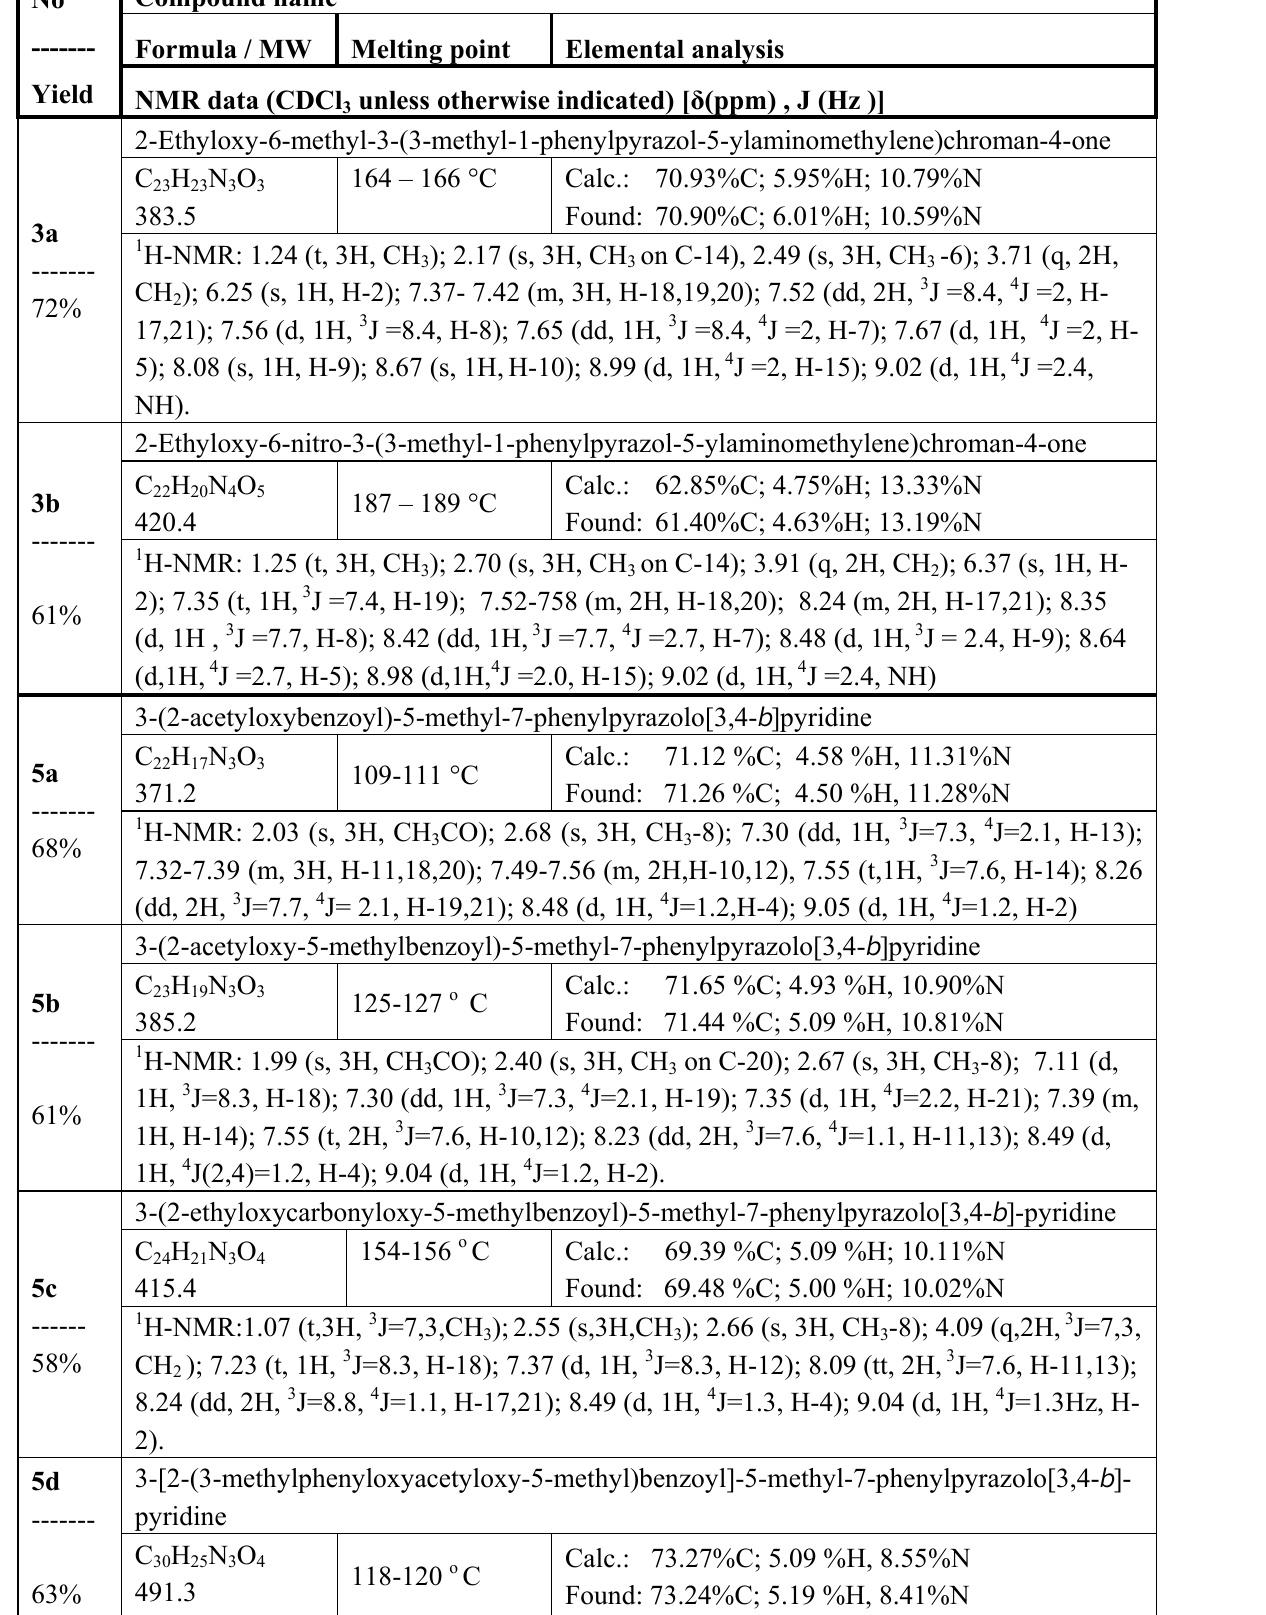
Table 4: Physical and 1 H-NMR data for compounds